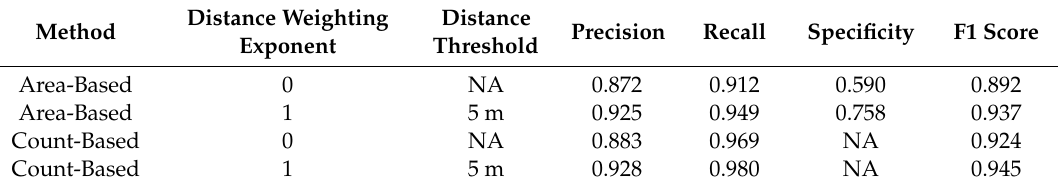
Table 5. Results for individual tree crown delineation.